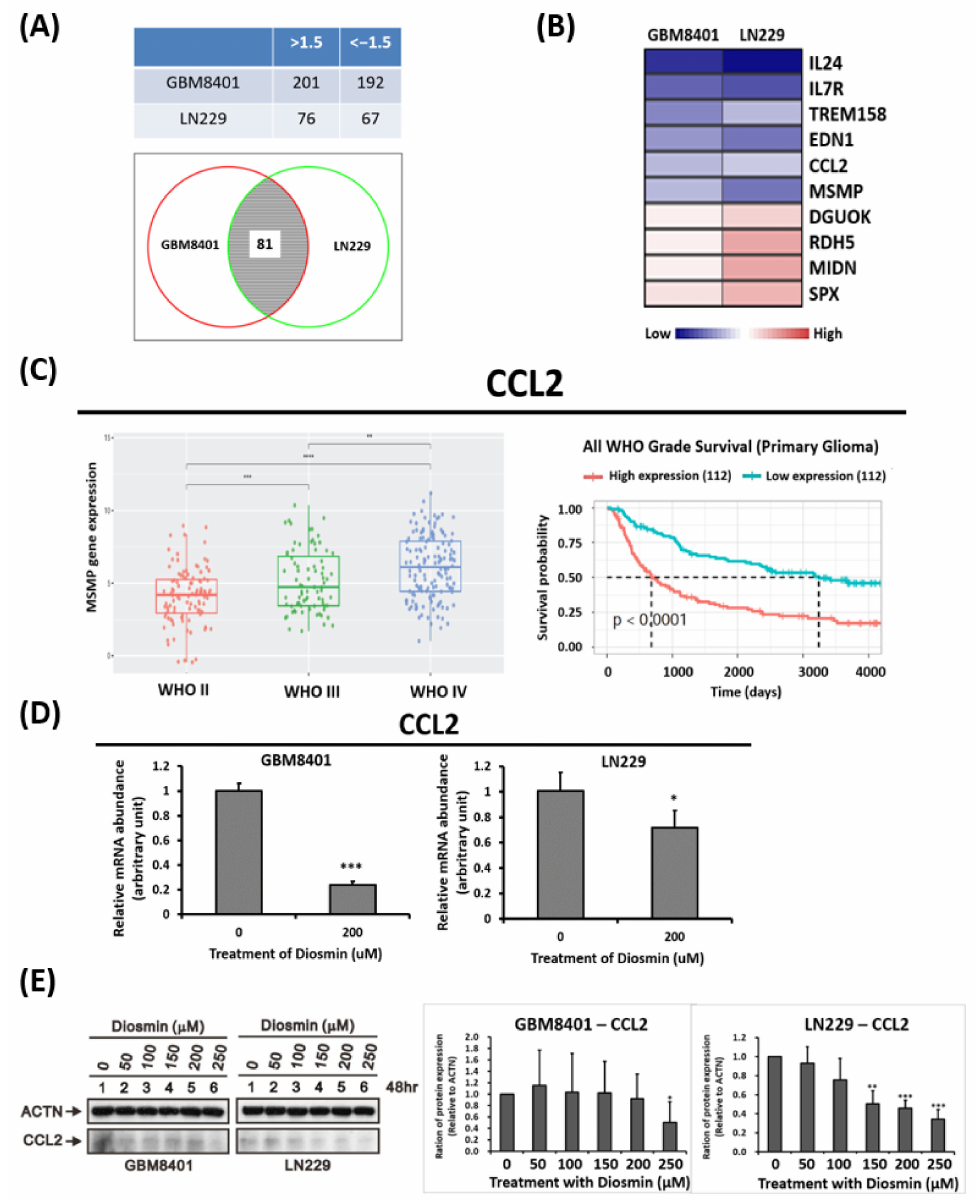
Figure 5. Differentially expressed genes in GBM8401 and LN229 cells treated with 160 µ M of diosmin for 48 h. ( A ) Numbers of differentially expressed genes with at least a 1.5-fold change in GBM8401 and LN229 cells are listed (top panel). The Venn diagram shows that expression of 81 genes is influenced by diosmin in both cell types (bottom panel). ( B ) Heat map showing the expression levels of the top 10 mutually upregulated and downregulated mRNAs in GBM8401 and LN229 calls. ( C ) Quantification across WHO grade II-IV ( C , left panel) and Kaplan–Meier survival analysis ( C , D , right panel) of C-C motif chemokine ligand 2 (CCL2) mRNA levels in the Chinese Glioma Genome Atlas (CGGA) RNA sequencing dataset. ** p < 0.01; *** p < 0.001; **** p < 0.0001 ( D , E ) real- time RT-PCR analysis of CCL2 mRNA ( D ) and protein ( E ) expression in GBM8401 and LN229 cells treated with 200 µ M of diosmin. The quantification of proteins was shown in the right panel ( n = 3). WHO, World Health Organization; Bars indicate means ± S.D.; * p < 0.05, ** p < 0.01, *** p < 0.001 vs. control